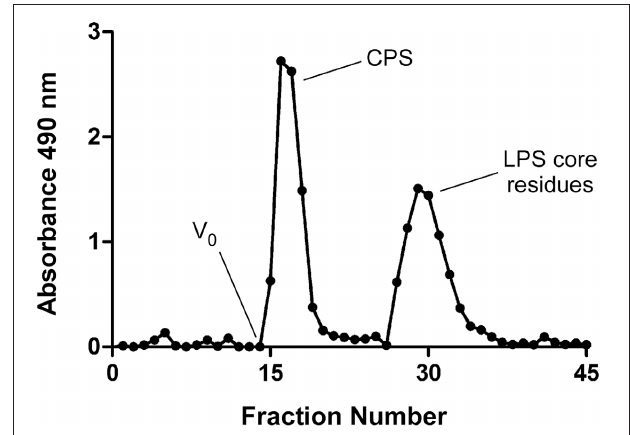
FIGURE 1 | Elution profile of column purified B. pseudomallei CPS. Acid hydrolyzed BP2683 CPS was loaded onto a Sephadex G-50 column and eluted with PBS. Carbohydrate positive fractions eluting near the column void volumes (V o ) were collected and pooled for further